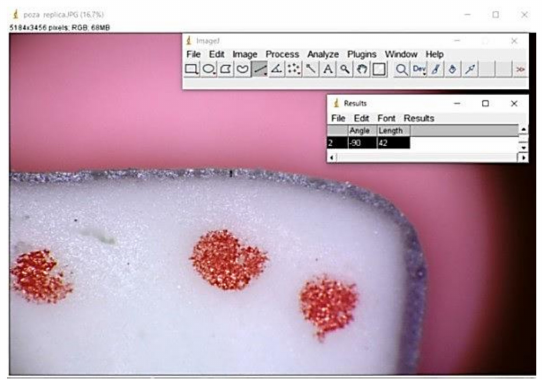
Figure 4. Replica technique with silicon in ImageJ.